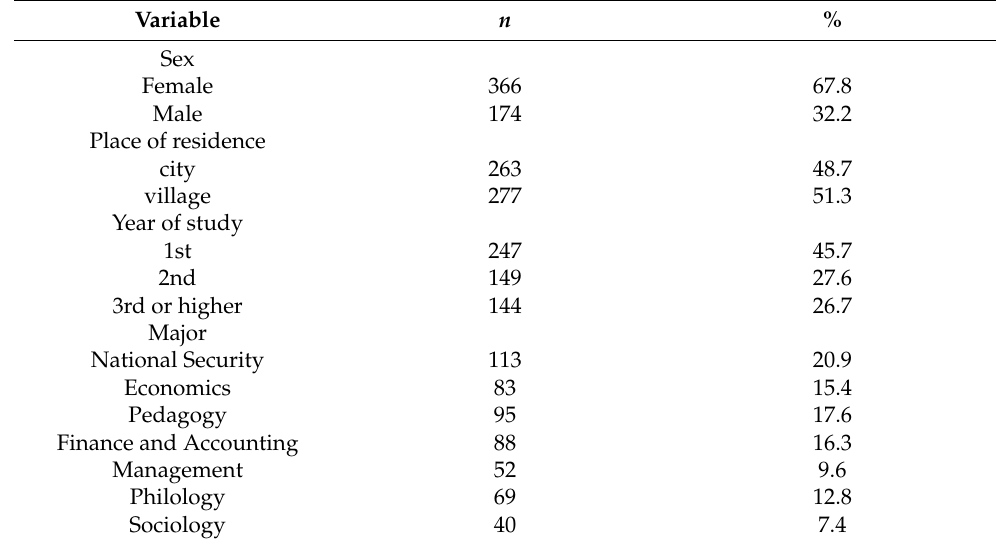
Table 1. Characteristics of the respondents ( n =